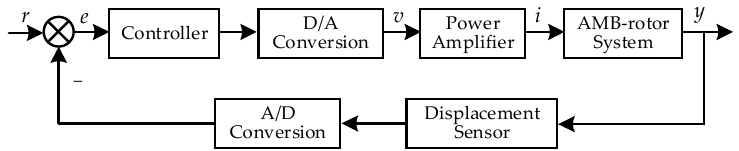
Figure 2. Control schematic diagram of the maglev system.